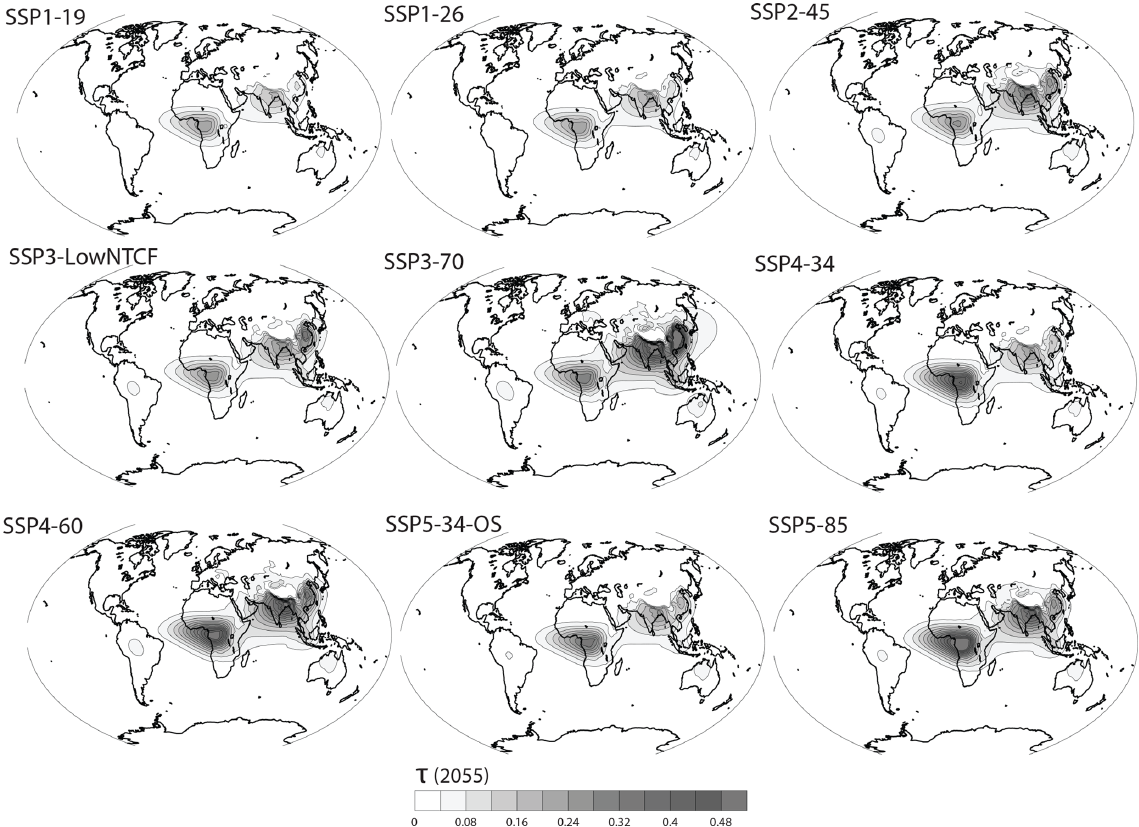
Figure A2. τ scenarios for the mid-2050s in MACv2-SP. Shown are the spatial distributions of τ at 550nm in the mid-2050s for each of the nine emission scenarios of